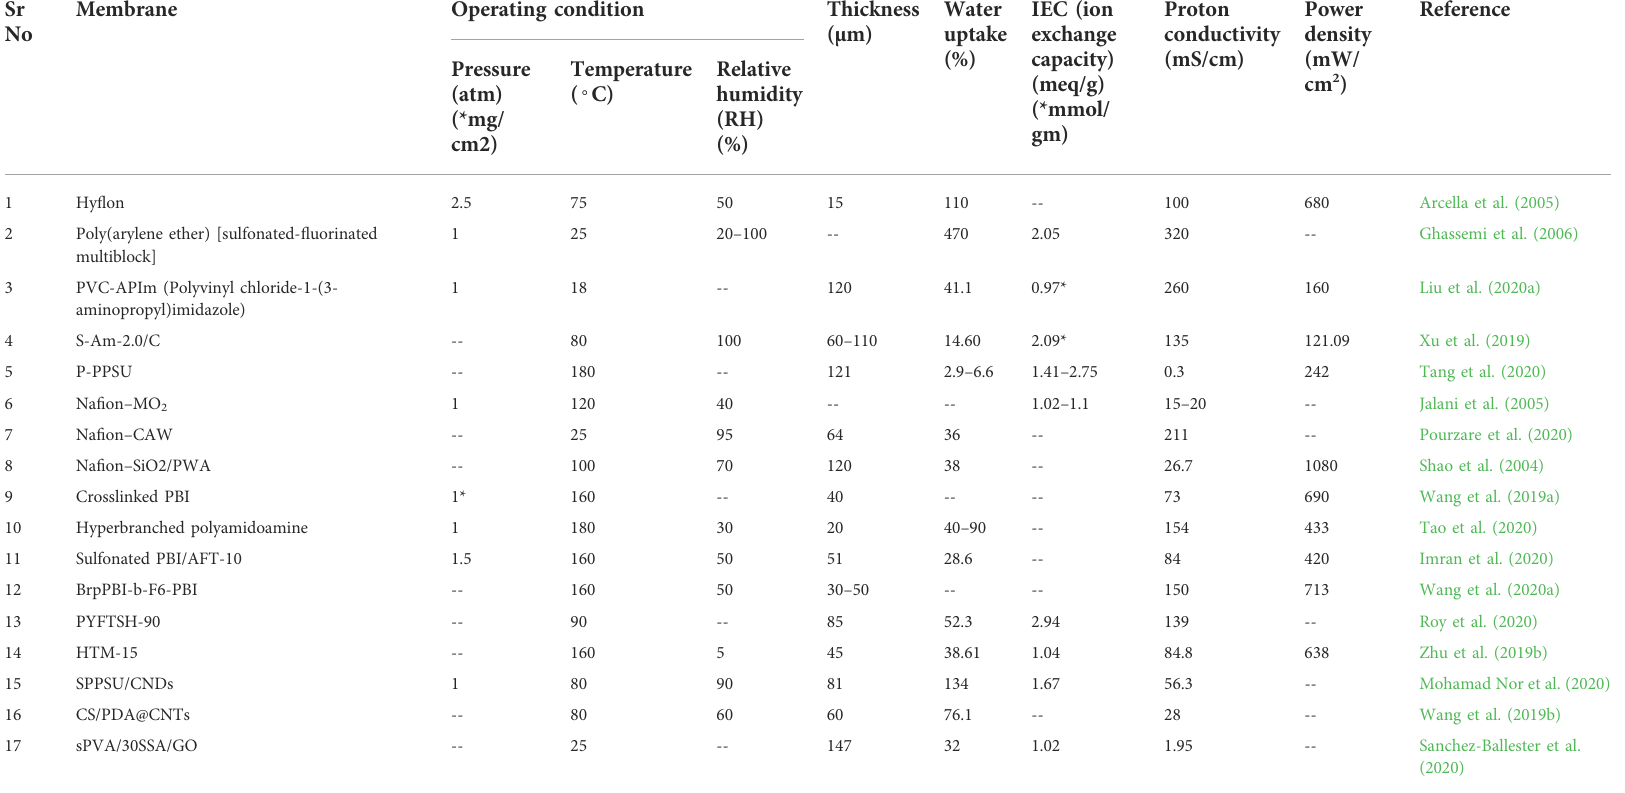
TABLE 3 Comparison of high-temperature PEMs based on thickness, water uptake, IEC, proton conductivity, and power density. Sr